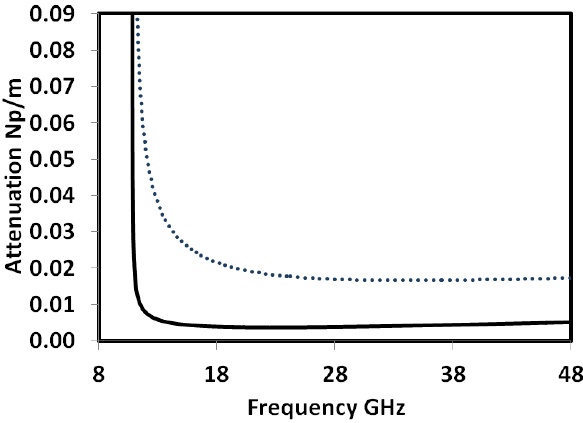
Figure 4: Attenuation of TE11 mode immediately above cutoff in a Nb circular waveguide (with 8.1 mm radius), operating at 4.2 K (solid line) and room temperature (dotted